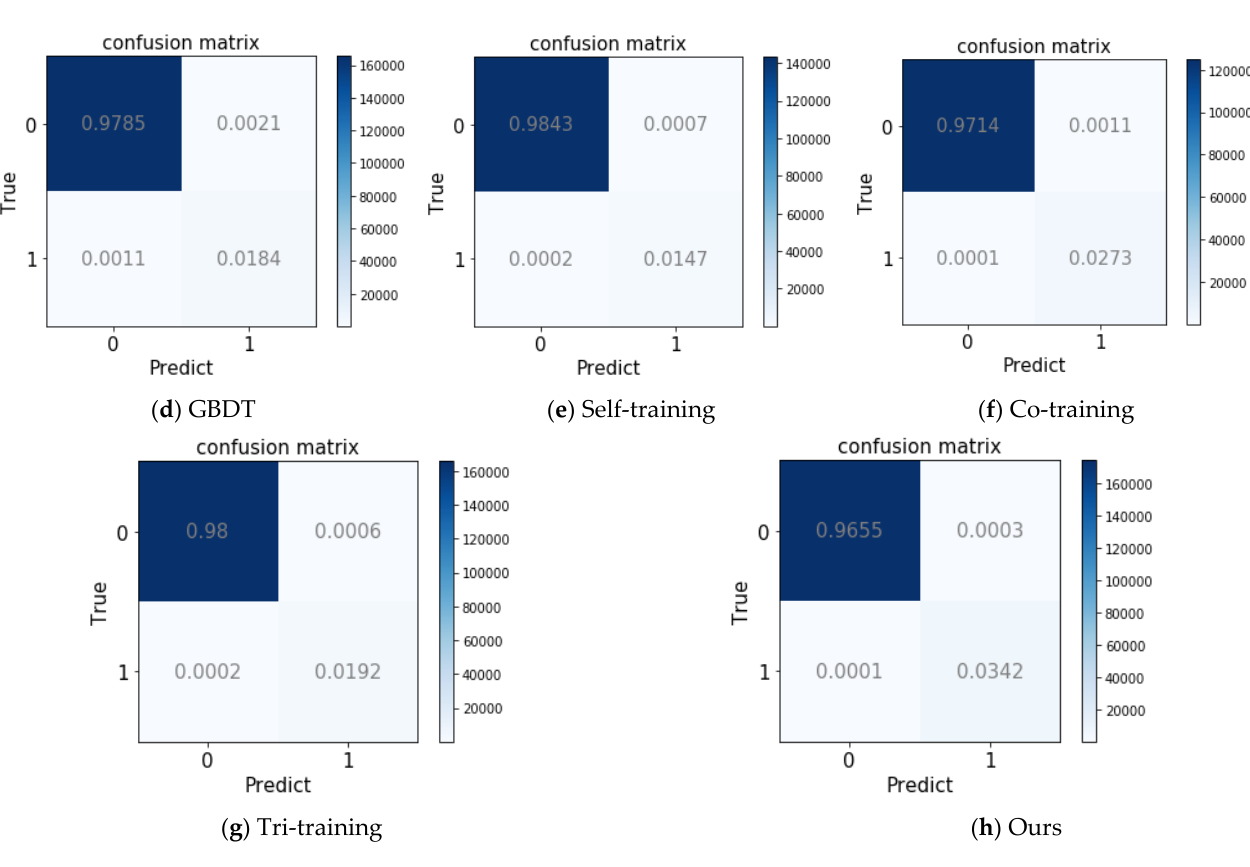
Figure 5. The confusion matrix for each model: ( a – h ) the confusion matrices obtained using the edX dataset with different models when K = 2 and train:test = 5:5.